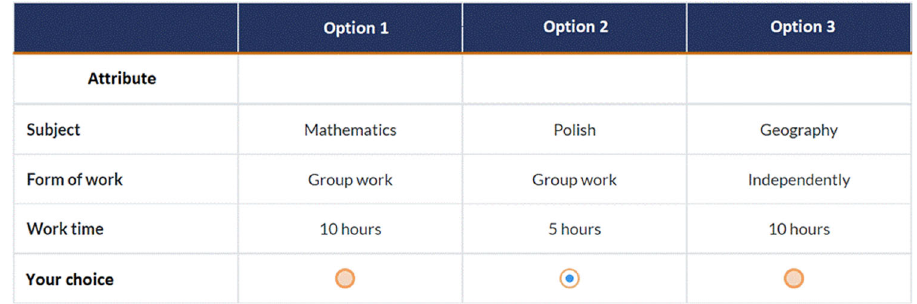
Fig. 1 An example of the discrete choice experiment choice set item. Source: Competences 2018